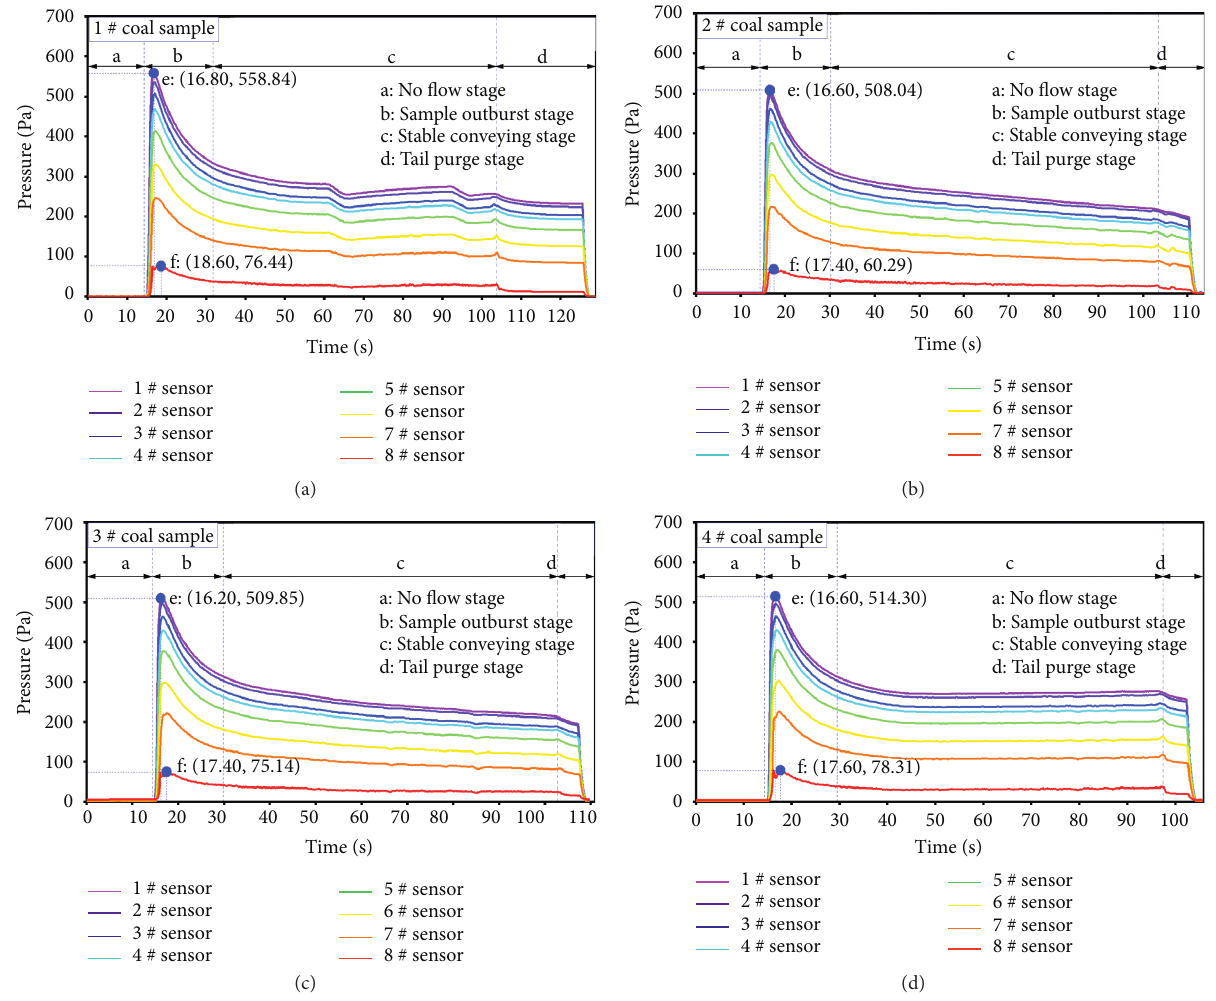
Figure 4: Pressure variation in the pipeline during the tests of the mixture sample. Point “e” represents the extreme pressure point of 1# sensor, and point “f” represents the extreme pressure point of 8 #